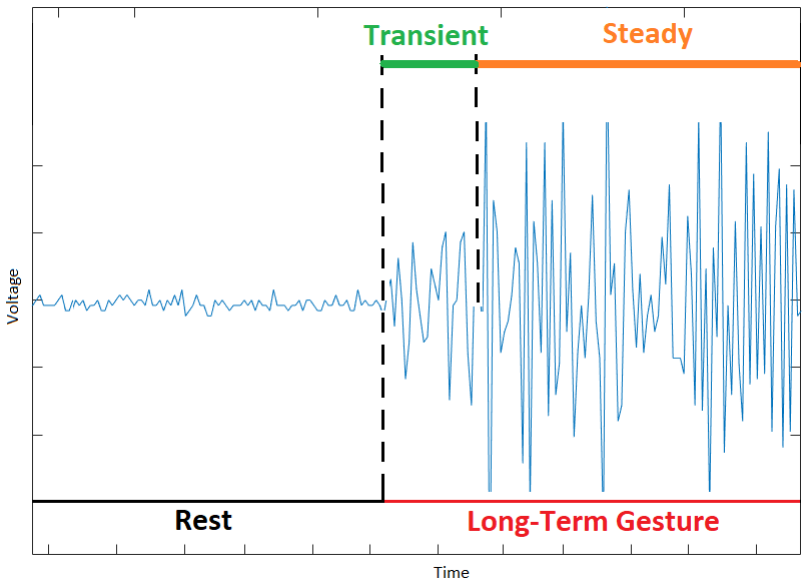
Figure 5. The EMG data of a long-term peace gesture (most of the EMG data are in the steady state).